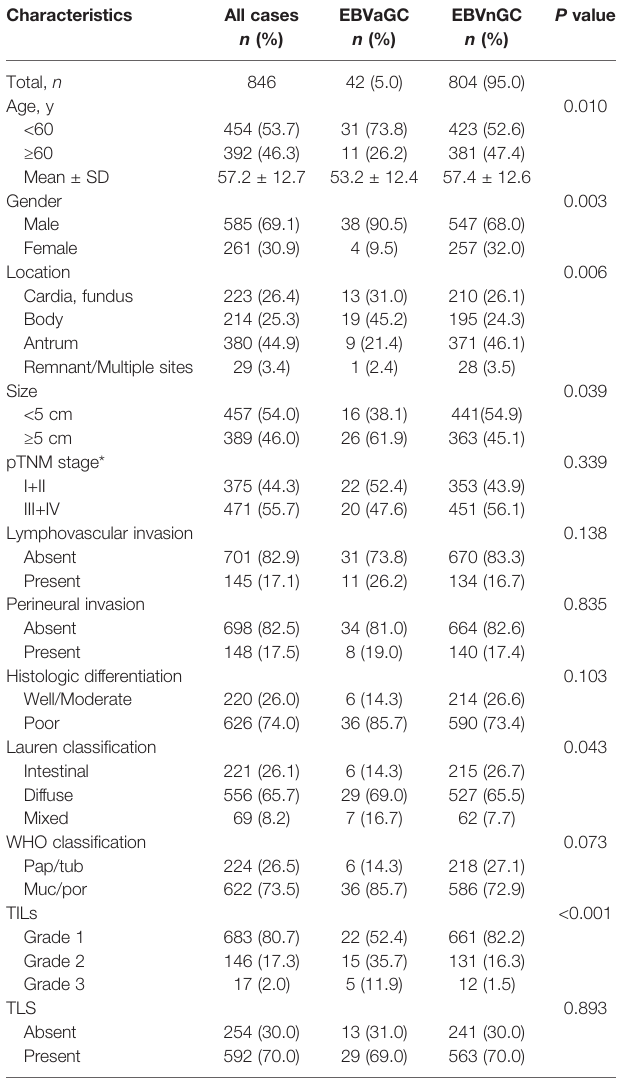
TABLE 1 | Clinicopathological characteristics of EBVaGC and EBVnGC.